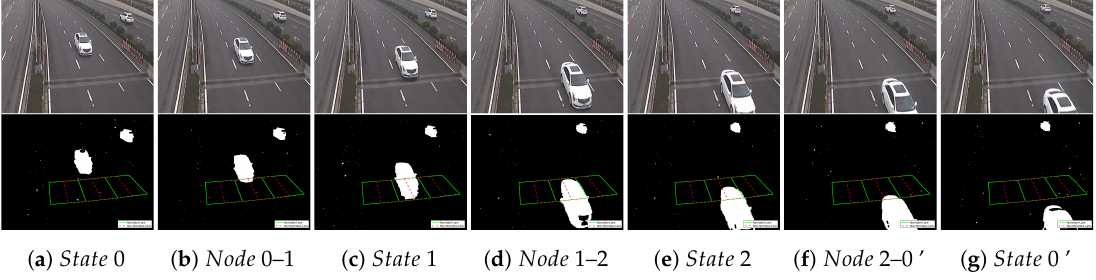
Figure 9. The instruction of nodes and states. (The sequences are from Video Zhongshan Rd [28]). Table 5. Judgement of State n & n + 1 . k